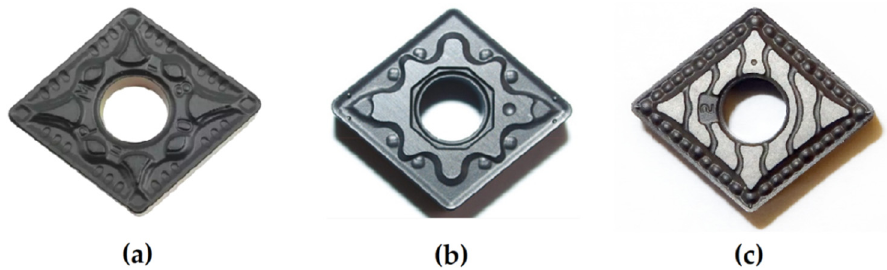
Figure 1. Indexable inserts used in tests: ( a ) CNMG 120408-PM 4315, ( b ) CNMG 120408E-M GRADE T9315, and ( c ) CNMG 120408-MP3 WPP10S.